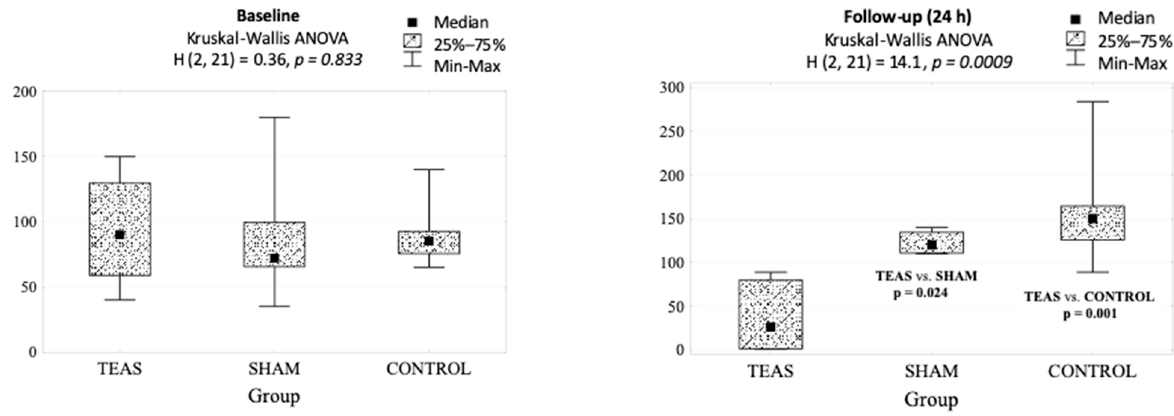
Figure 5. Cortisol levels (ng/mL) at baseline and follow-up in groups differing in the type of intervention and the result of the analysis of variance and multiple comparisons (Kruskal–Wallis ANOVA).